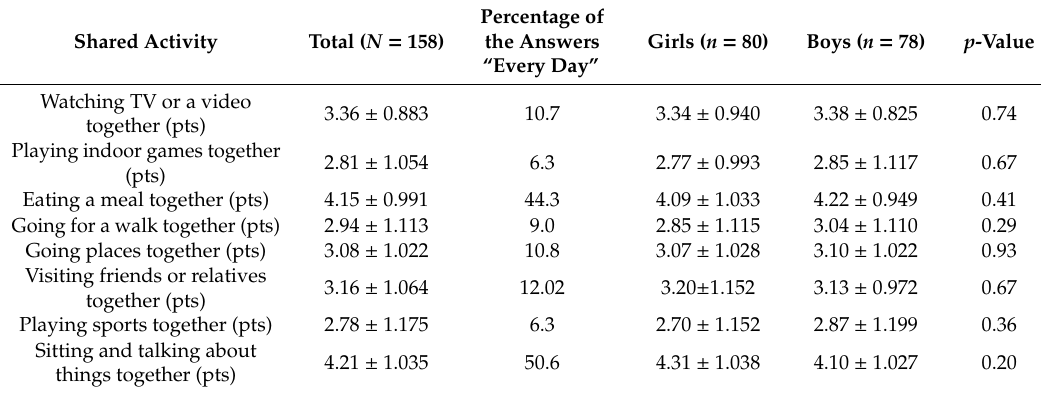
Table 3. Means and standard deviations of responses to questions on family time spent together in shared